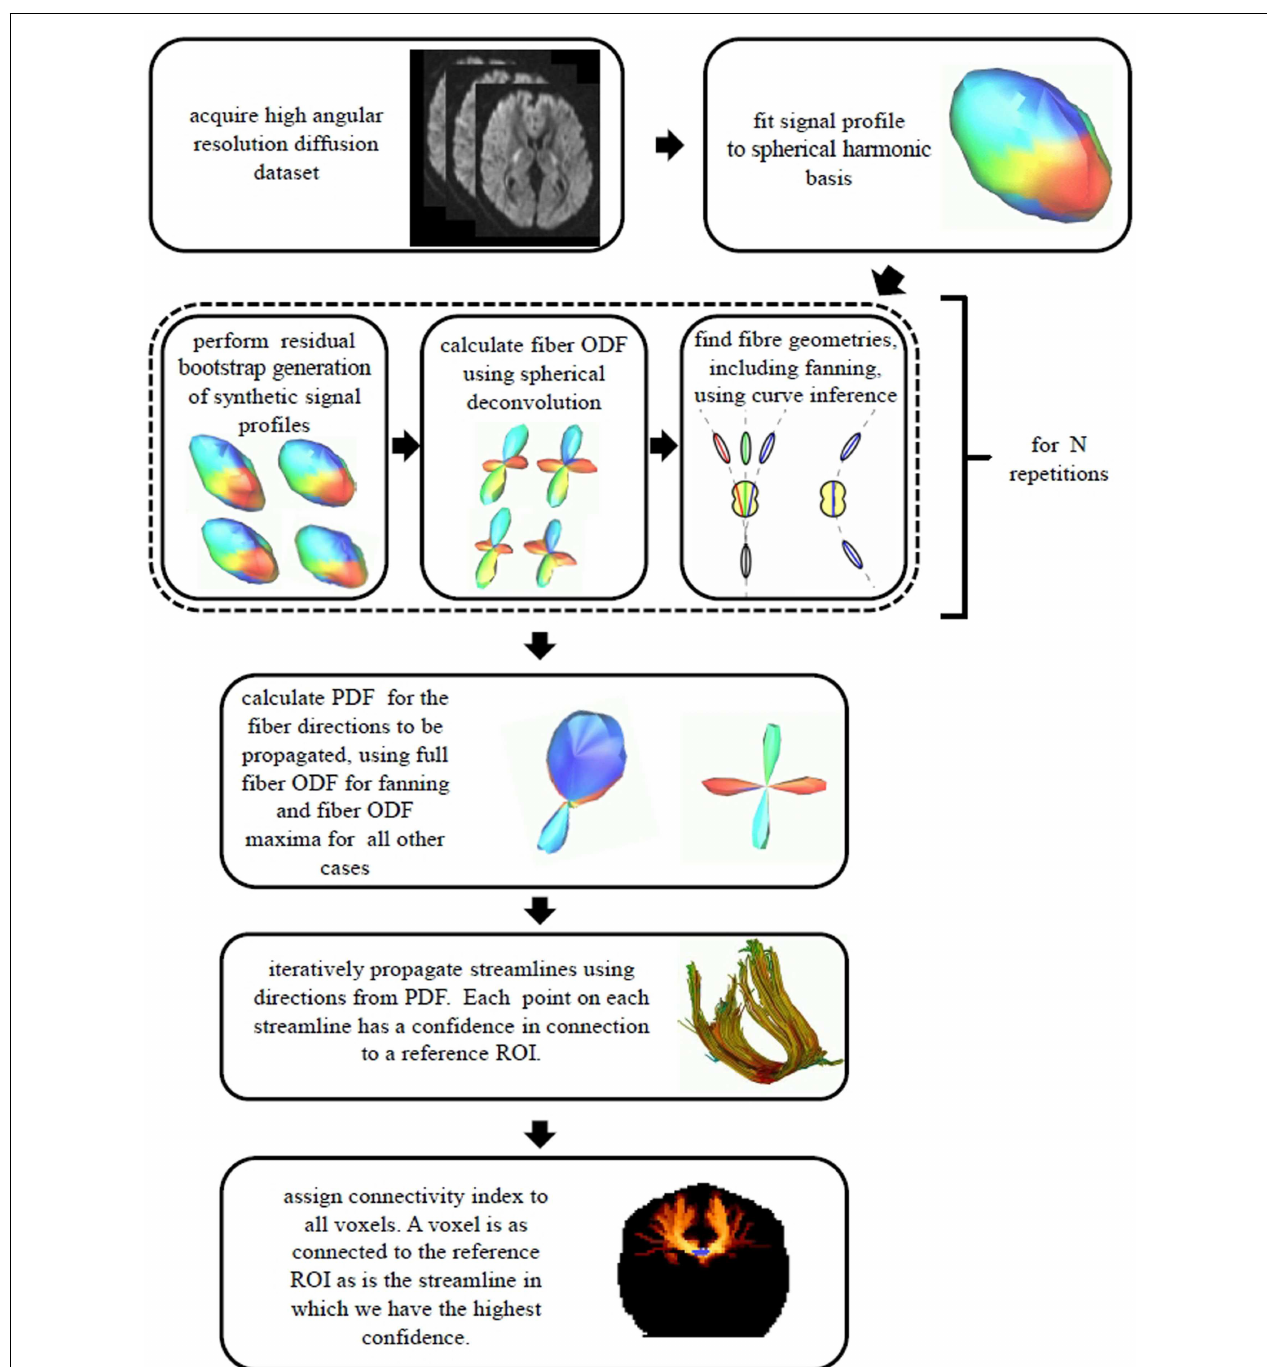
FIGURE 4 |A summary of the data processing pipeline for the combined curve inference labeling and bootstrap probabilistic tractography is shown .